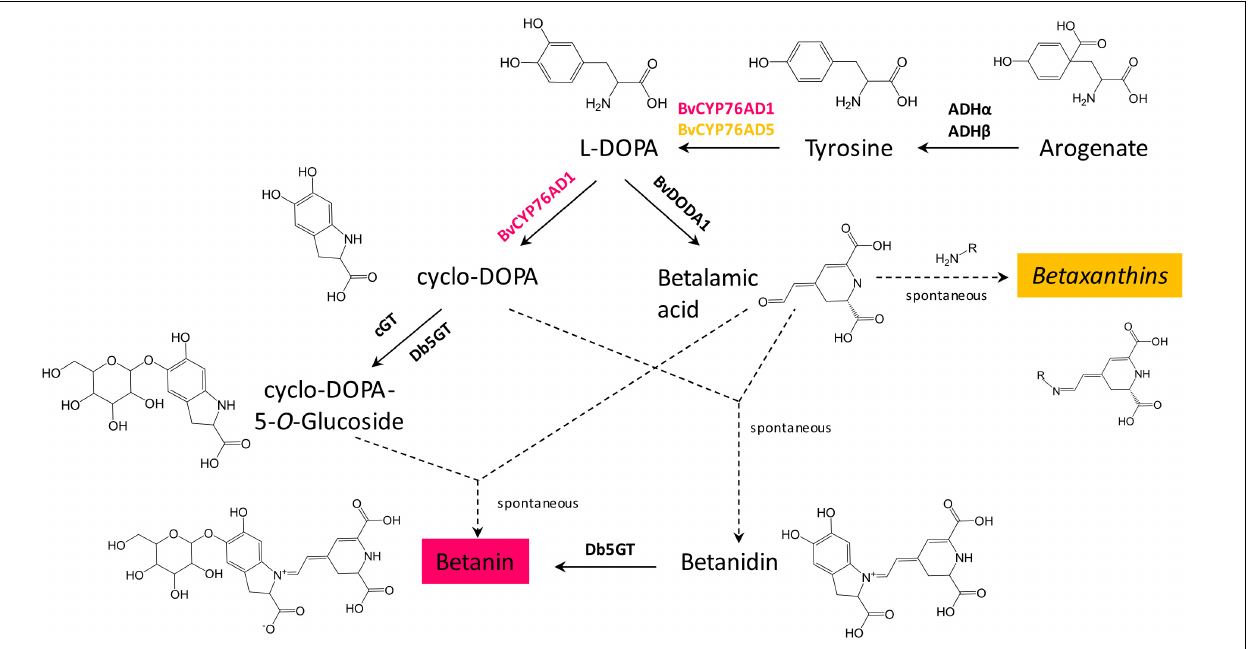
FIGURE 1 | Genes involved in betalain biosynthesis. Two genes are involved in biosynthesis of L-DOPA from tyrosine, BvCYP76AD1 (shown in red, as it is mostly involved in betacyanins biosynthesis) and BvCYP76AD5 (shown in yellow, as it is involved in biosynthesis of betaxanthins). In Beta vulgaris , two arogenate dehydrogenases, ADH α and ADH β , are involved in biosynthesis of the precursor of betalains, tyrosine. Dashed arrows indicate spontaneous reactions.